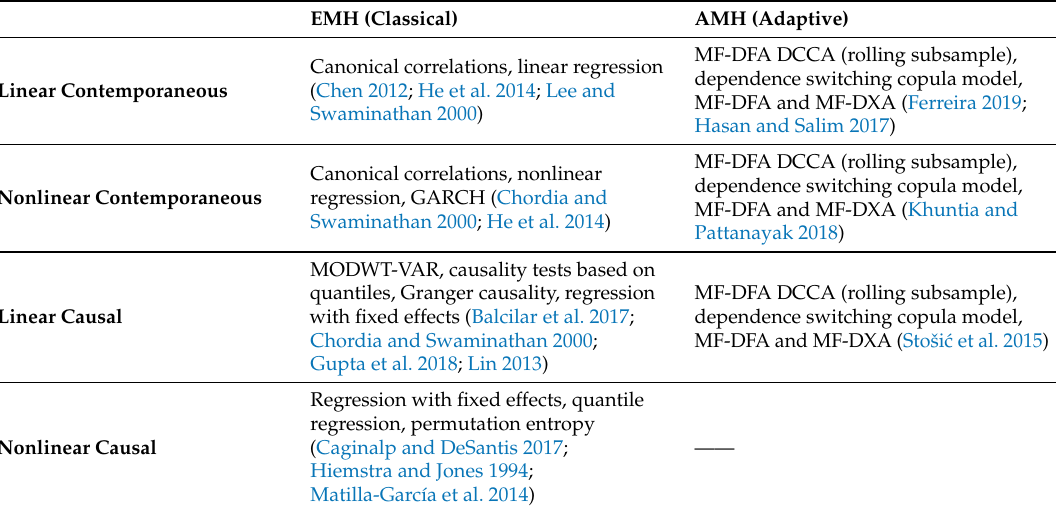
Table 2. Review matrix for price–volume relationship